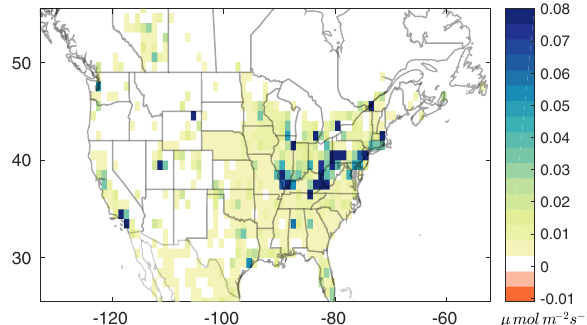
Figure 3. US methane emissions from EDGAR v3.2 FT2000 at the native 1 ◦ by 1 ◦ resolution. The largest source regions, New York and eastern Kentucky, have fluxes higher than 3 times the limit of the color map.